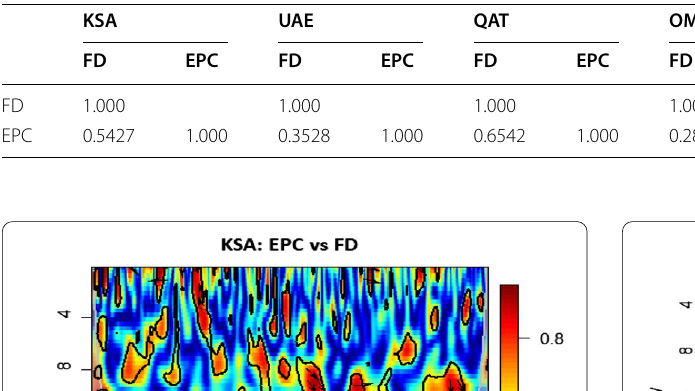
Table 2 Correlation matrix between the study variables in GCC